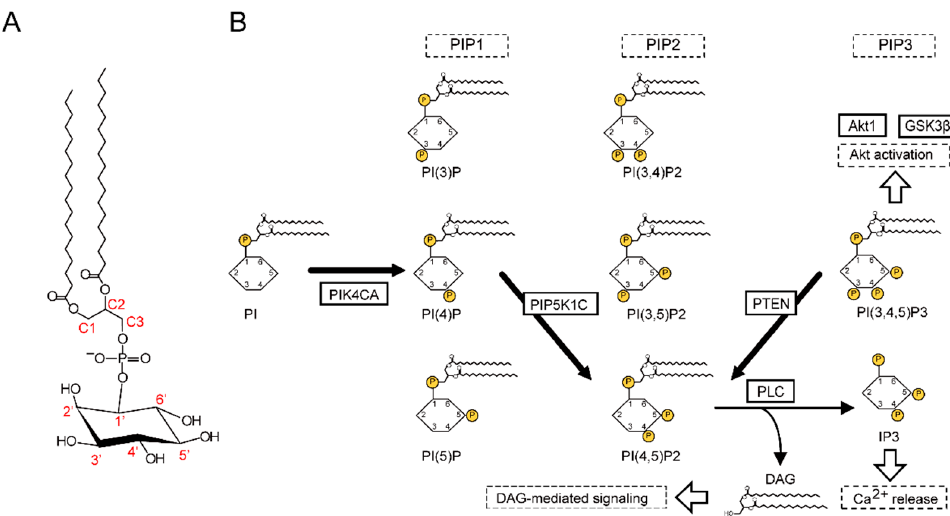
Figure 1. ( A ). Structure of phosphatidylinositol (PI). PI is composed of fatty acid residues attached to the C1 and C2 positions of the glycerol backbone, and inositol is attached via phosphate at the C3 position. The hydroxyl groups at positions 3 ′ , 4 ′ , and 5 ′ of the inositol head can undergo additional phosphorylation. As there are more than 30 different combinations of fatty acid residues and 8 different phosphorylation states are possible, there are more than 240 molecular species of PI in vivo. ( B ). Schematic diagram of phosphoinositide signaling and associated proteins analyzed in this study.